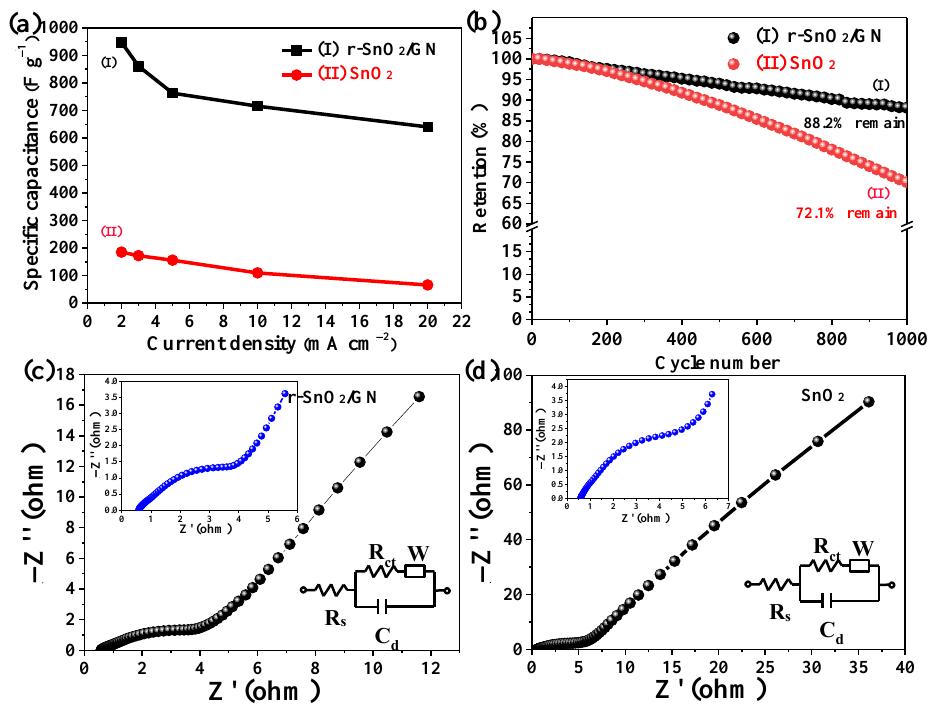
Figure 7. ( a ) Specific capacitance as a function of current density; ( b ) The cycle stability; EIS Nyquist plots and the equivalent circuit model (the inset) for electrodes ( c ) r-SnO 2 /GN and ( d ) SnO 2 . Table 1. The brief summary of electrochemical performance of SnO 2 -based supercapacitors. Electrode Materials Electrolyte Current Density Specific Capacitance (F g − 1 ) Ref. SnO 2 SnO 2 -NGO Hollow SnO 2